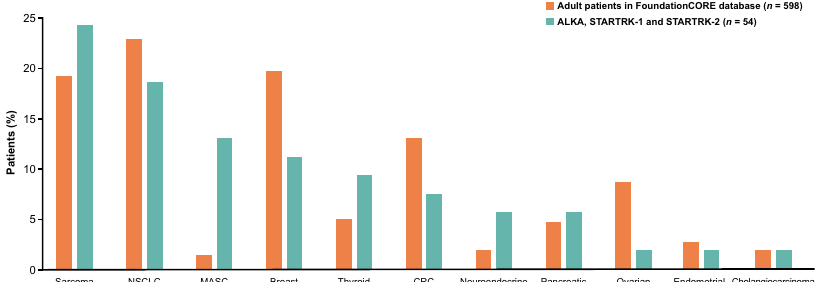
Fig. 5 Comparisons of NTRK fusion-positive tumour types in entrectinib adult clinical studies versus FoundationCORE database. CRC colorectal cancer, MASC mammary analogue secretory carcinoma, NSCLC non-small cell lung cancer, NTRK neurotrophic tyrosine receptor